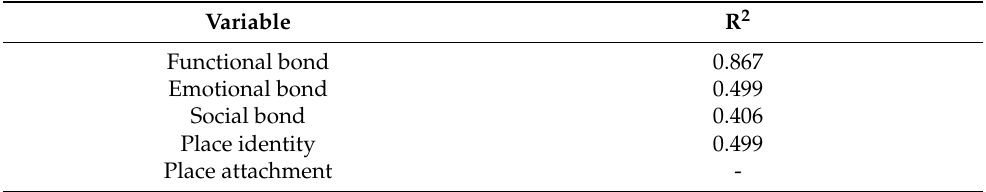
Table 3. Fitting the structural